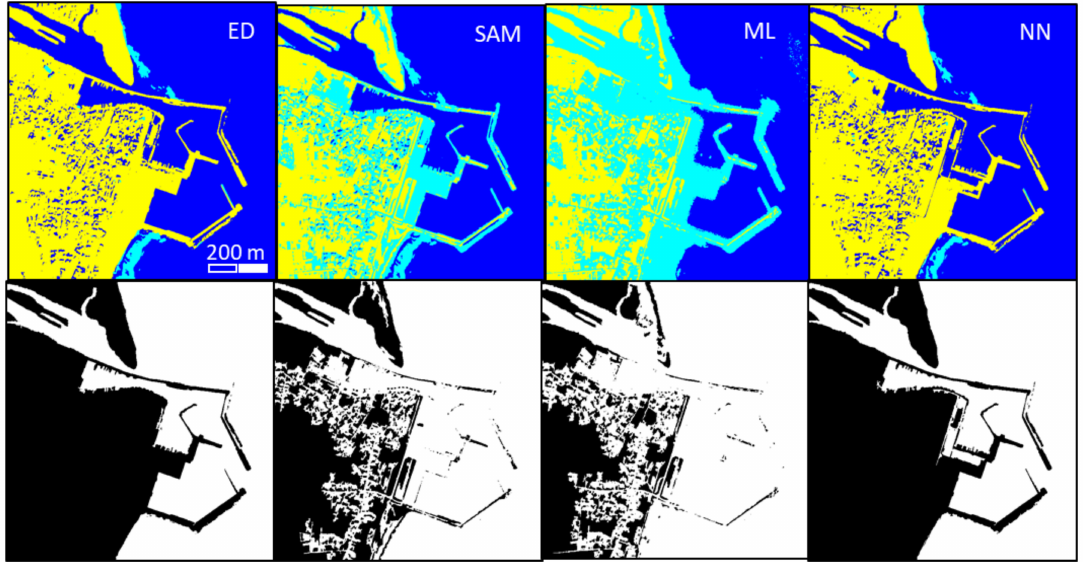
Figure 7. (Top panels) Pixel classification retrieved by the 4 methods described in Section 2 (Euclidean Distance (ED), Spectral Angle Mapper (SAM), Maximum Likelihood (ML), Neural Network (NN)) on 8 November 2010 for the southern area (Figure 1); 3 classes were used: land (yellow), foam (light blue) and water (blue). (Bottom panels) Land / ocean maps obtained after merging foam and water pixels using a segmentation procedure.